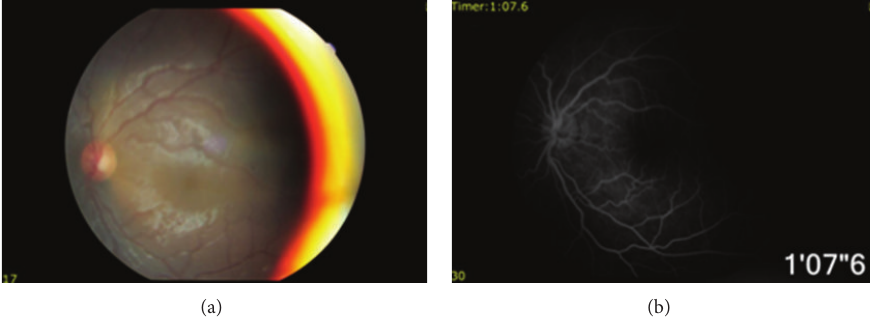
Figure 5: Funduscopic examination (a) and fundus fluorescein angiography (b) findings were within normal limits in the left